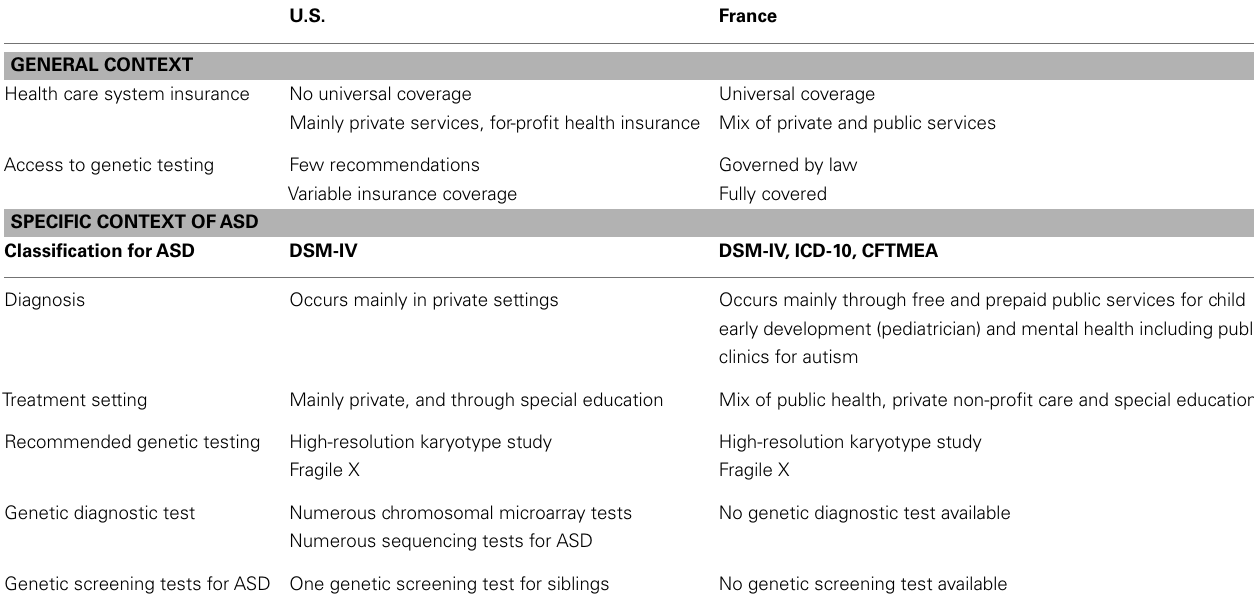
Table 1 |A brief overview of the use of genetic testing in the US and France.